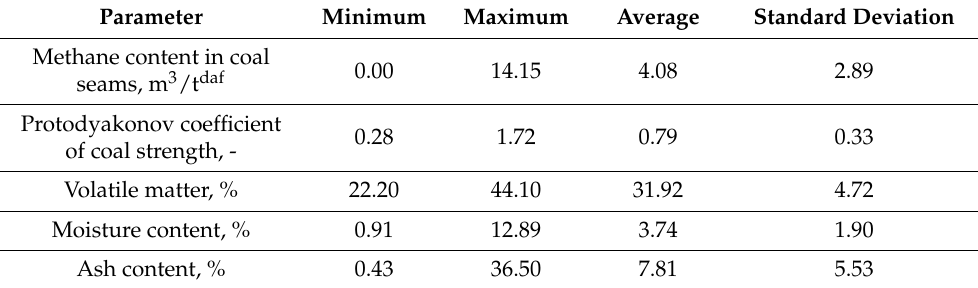
Table 1. Variation of selected physical parameters for coal